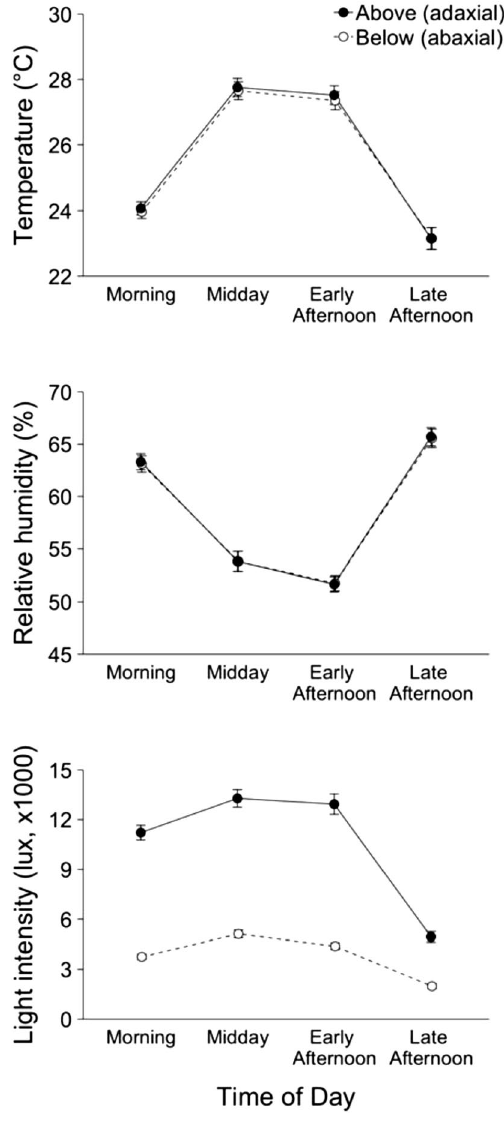
Figure 5. Average (± SE) abiotic conditions (temperature, relative humidity, and light intensity) above (adaxial) and below (abaxial) leaf surfaces where flies were observed throughout the